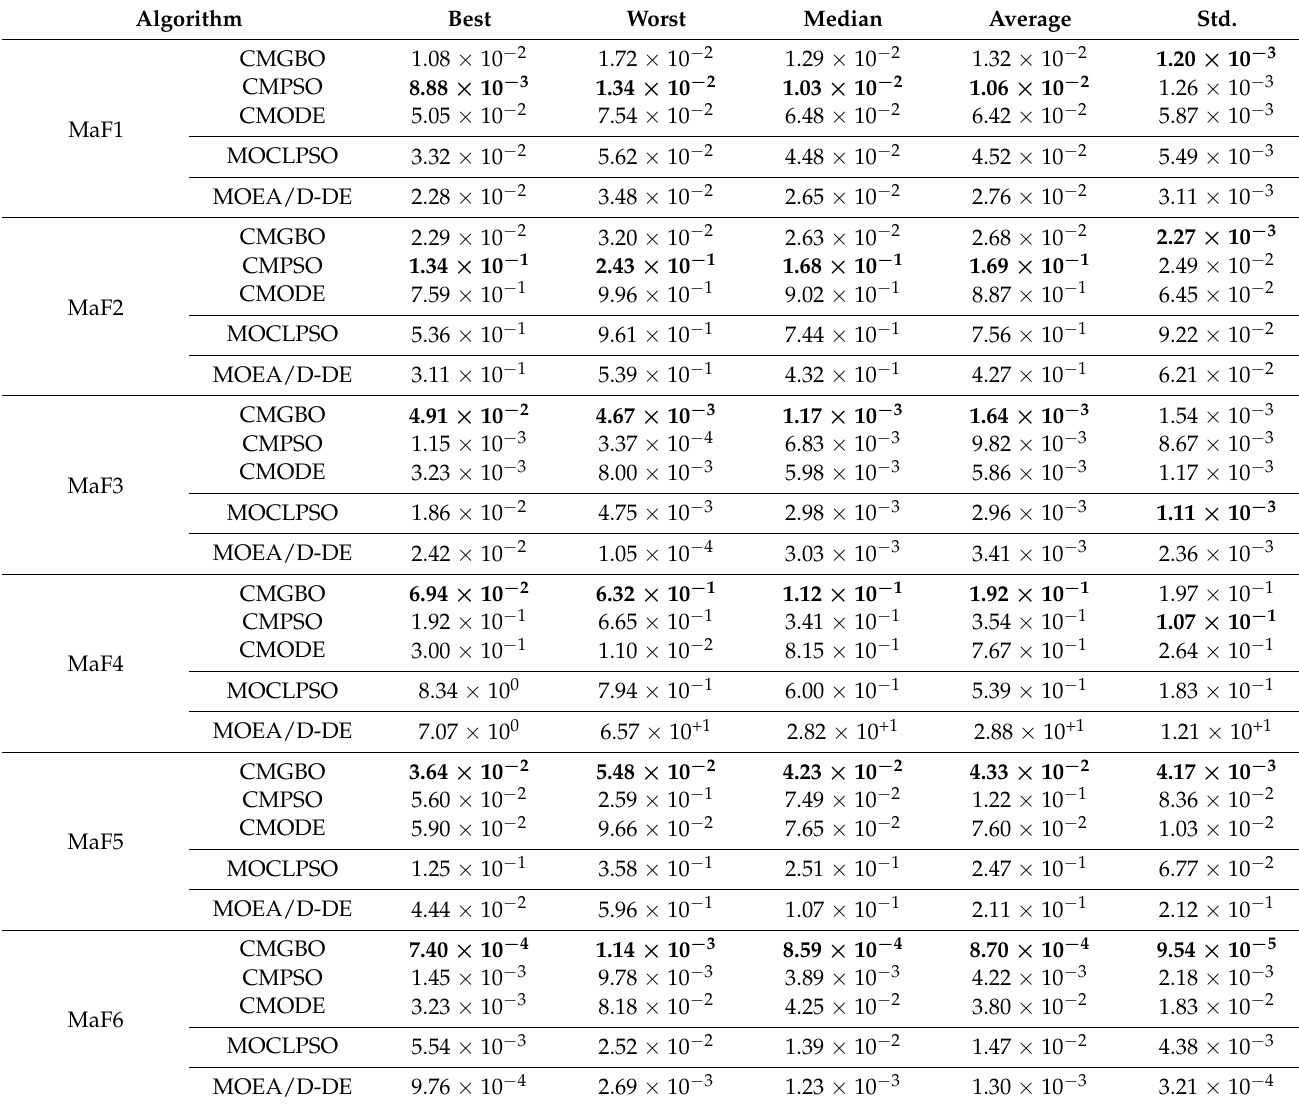
Table 5. Statistical results for IGD on MaF test